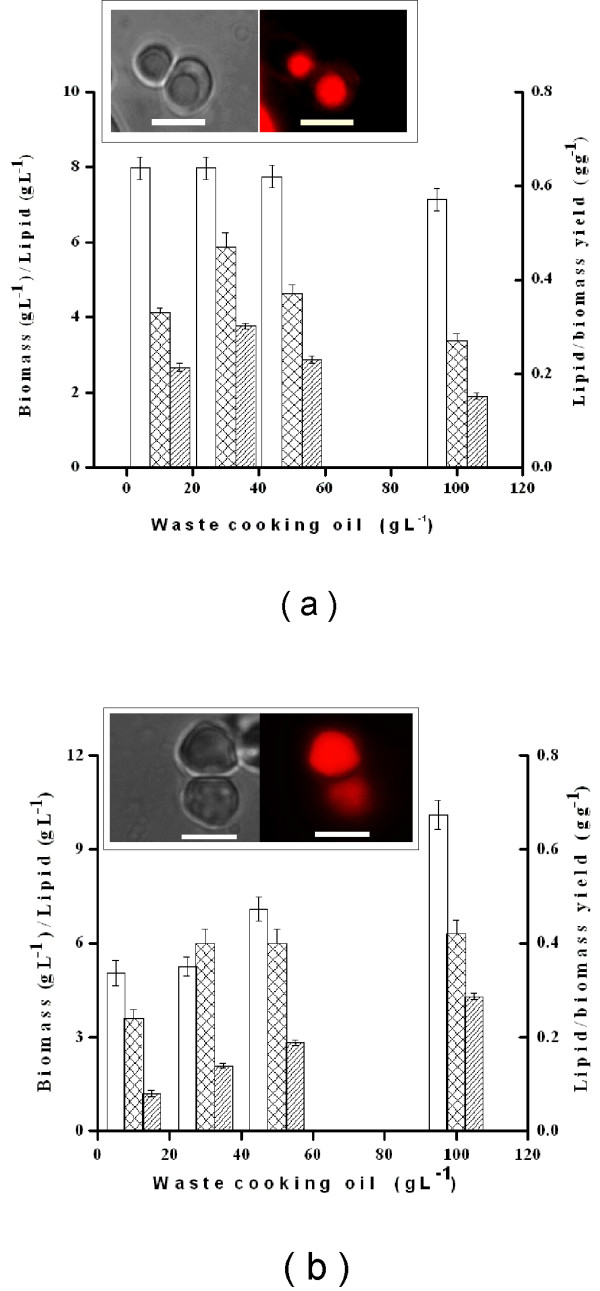
Biomass, lipid yield and lipid yield coefficients of Y. lipolytica NCIM 3472 and NCIM 3589 grown on varying concentrations of WCO. Bar (empty): Biomass (g L-1), Bar (oblique line): Lipid (g L-1), Bar (checkered): Lipid/biomass yield coefficient (g g-1). Inset In each graph light microscopy (left panel) and Nile red fluorescence microscopy (right panel) images of the respective Y. lipolytica strains under 100× oil immersion objective. Bar indicates 10 μm.